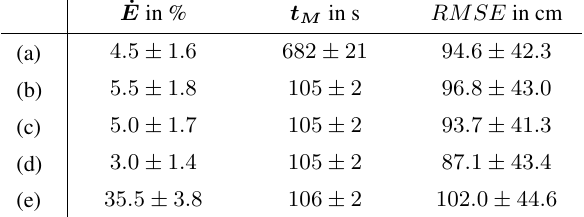
Table 4: Failure rate ˙ E , matching time t M , and accuracy of the coarse alignment (RMSE) of for the Urban data